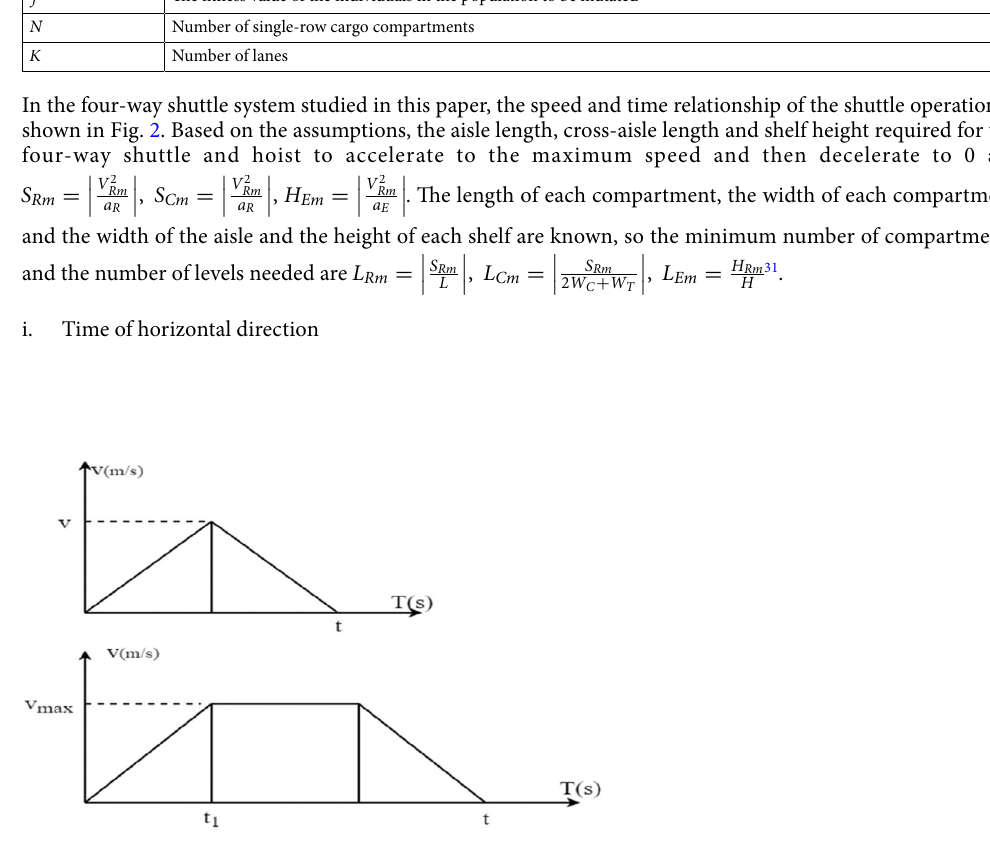
Figure 2. Four-way shuttle running speed versus